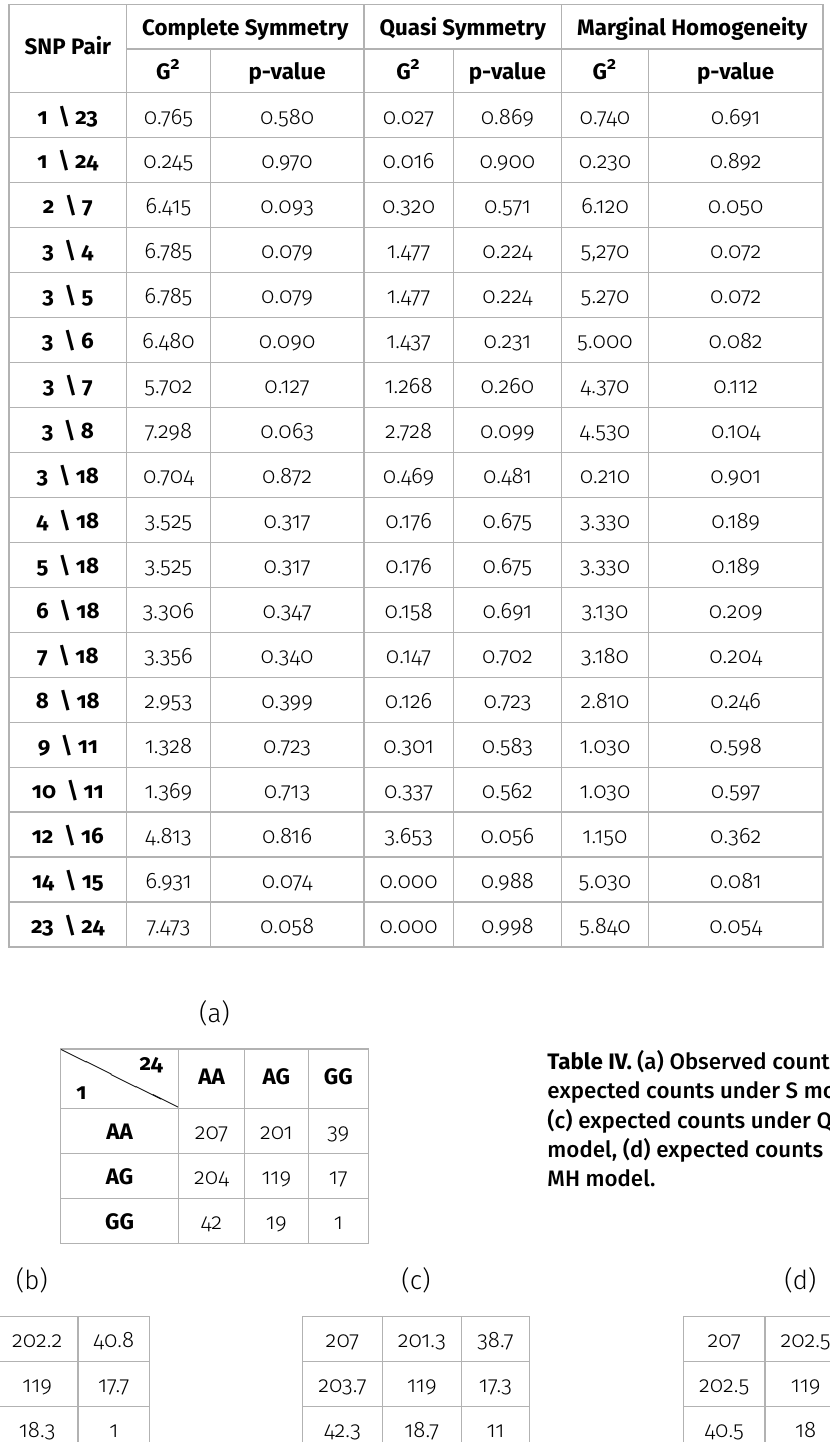
Table III. Results under symmetry models.